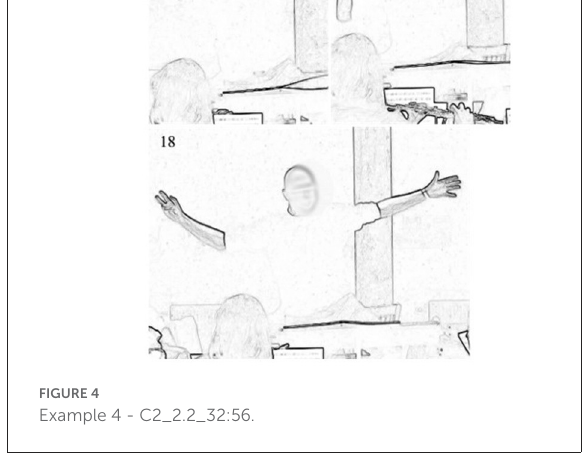
FIGURE4 Example 4 - C2_2.2_32:56.